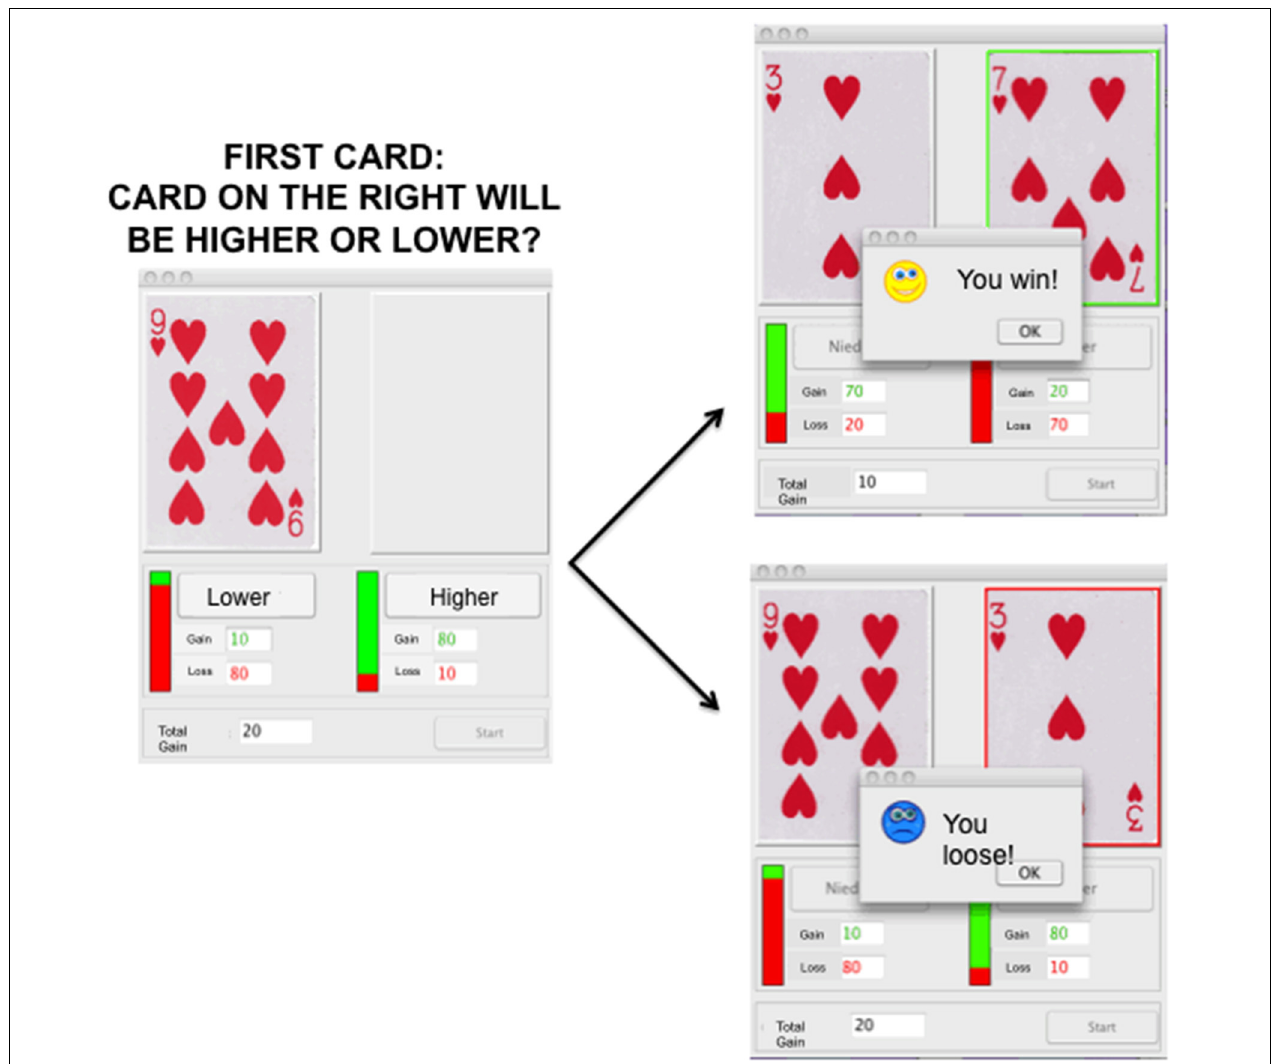
FIGURE 1 | Illustration of Haeglers Risk Game depicting the screen with one card on the left and the option of the participant to choose a lower or higher card will be displayed on the left. On the right the two alternatives, depicting either a win (top), or a loose (bottom) trial, are illustrated.